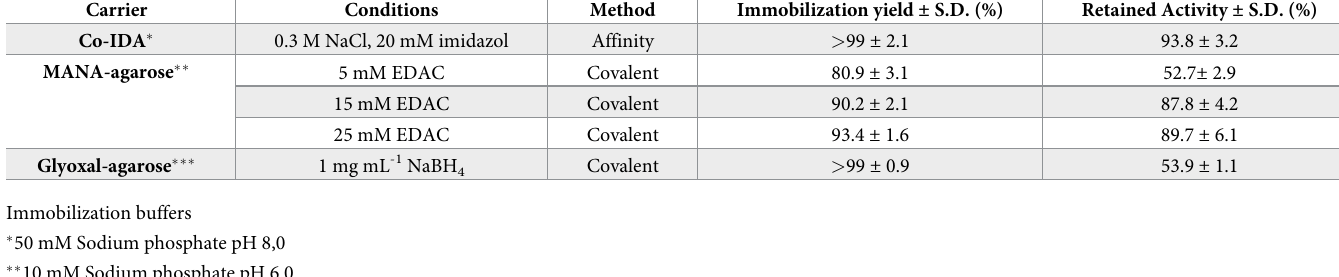
Table 1. Immobilization yield and retained activity of FSA immobilized by different methods on mesoporous supports. The immobilizations were performed at room temperature under mild agitation.